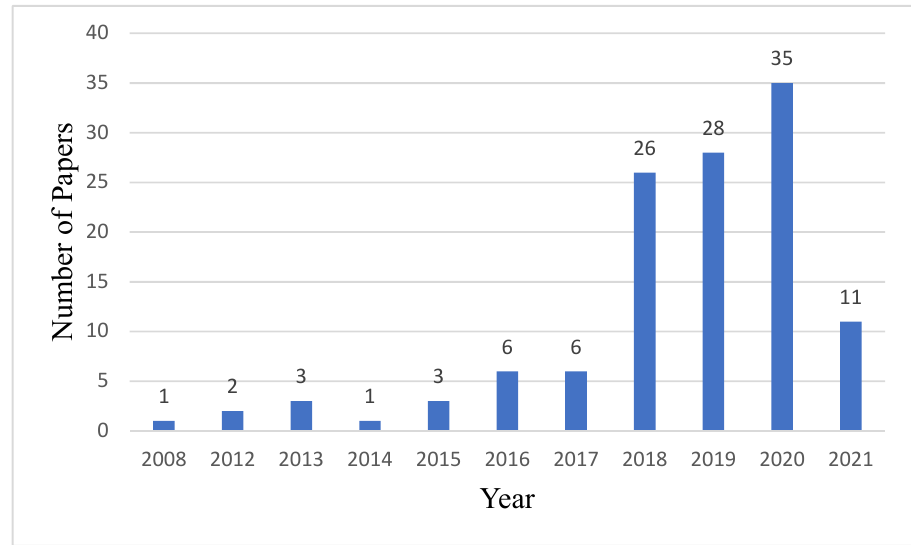
Figure 5 . Number of papers published in different years. Figure 5. Number of papers published in different